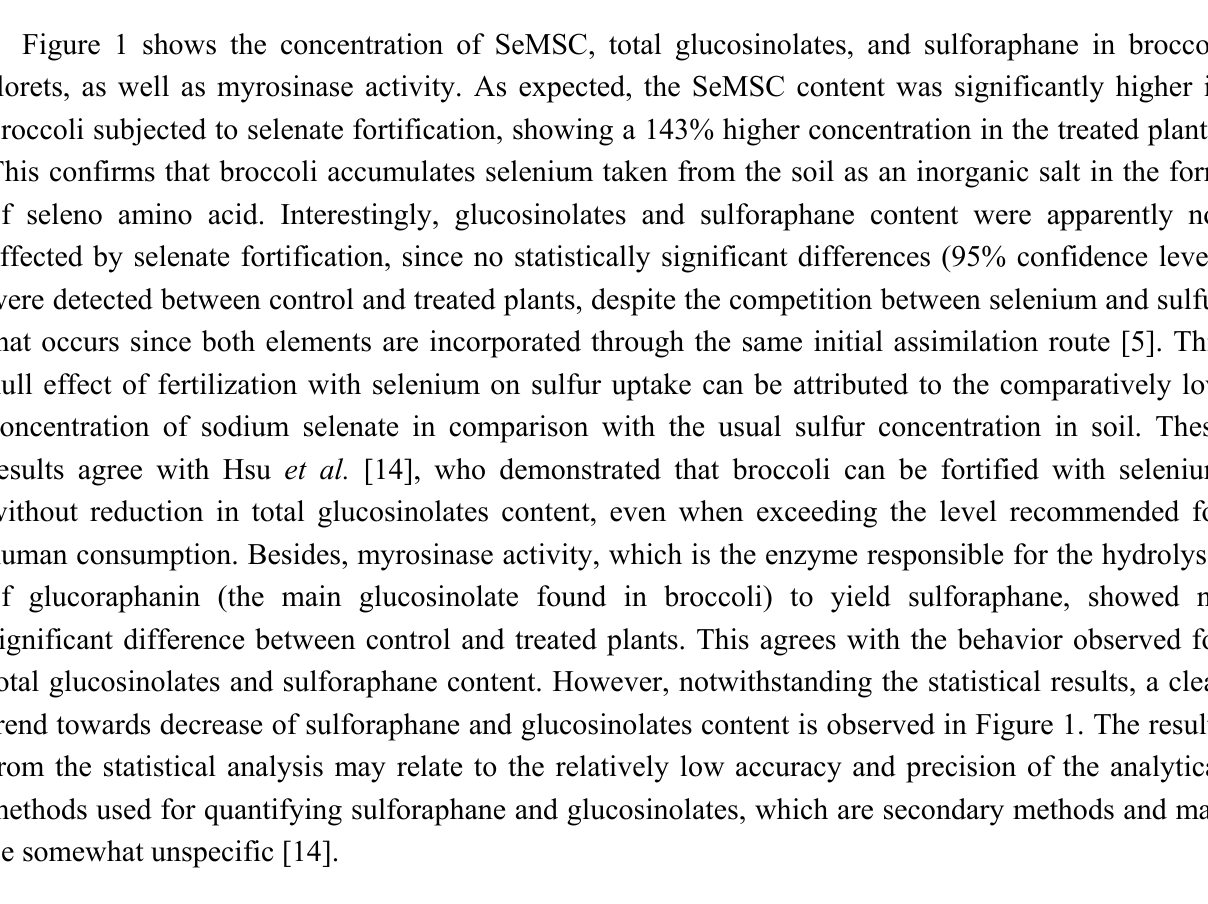
Figure 1. SeMSC, total glucosinolates and sulforaphane content and myrosinase activity in broccoli fertilized with water (control) or with 100 µM sodium selenate